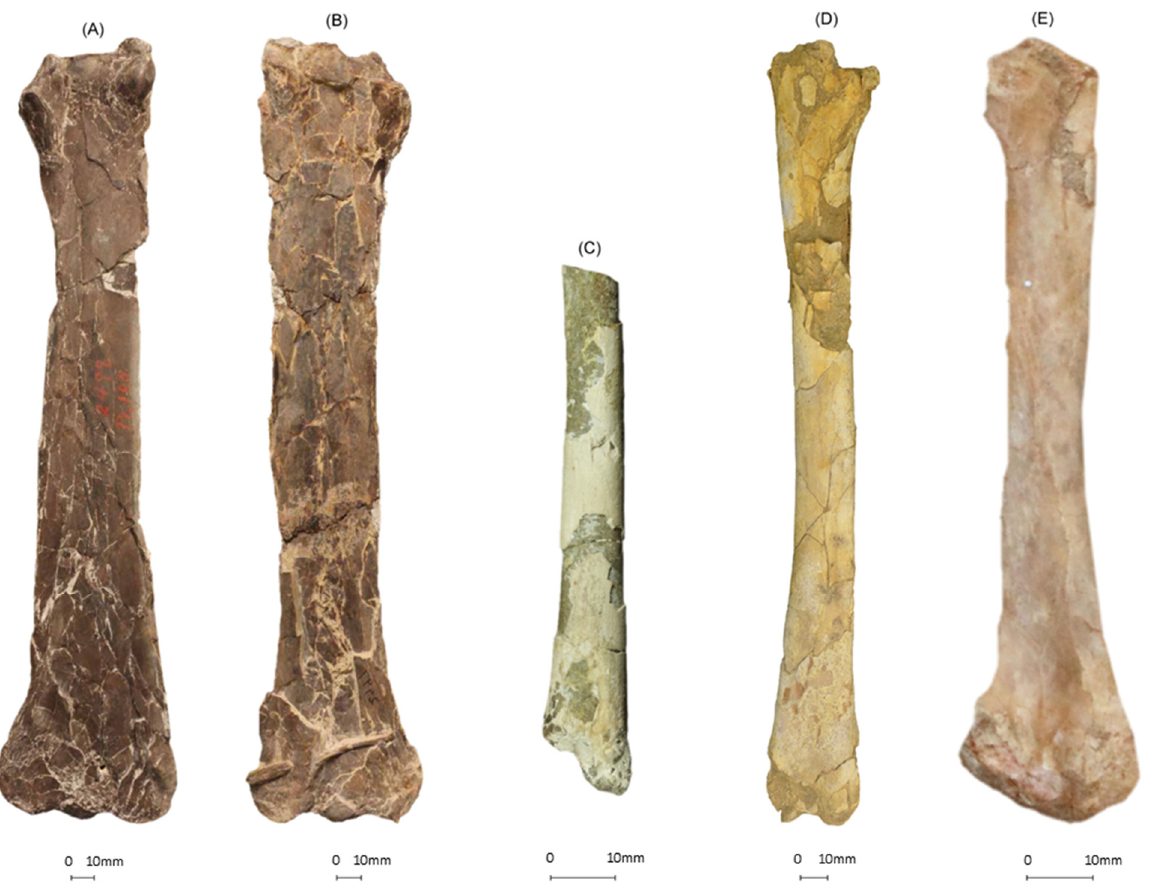
Figure 13. Comparison of pteranodontian ulnae. ( A , B ) YPM 2499 and YPM 2497 Pteranodon sp. (adapted from Longrich et al. 2018 [17]), ( C ) NMP Ob 10-14 Cretornis hlavaci Fri č 1881 (adapted from Averianov & Ekrt 2015 [21]), ( D ) MGUAN-PA650 Epapatelo otyikokolo , and ( E ) FSAC-OB 4 Alcione elainus (adapted from Longrich et al. 2018 [17]).